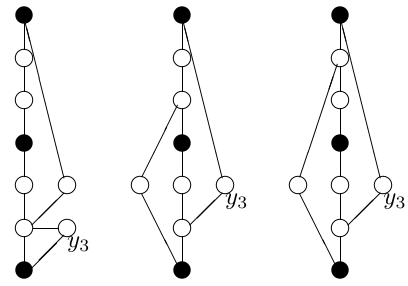
Fig. 13: Fixing v 7 for a maximum backbone tree of type 1 in case [5]